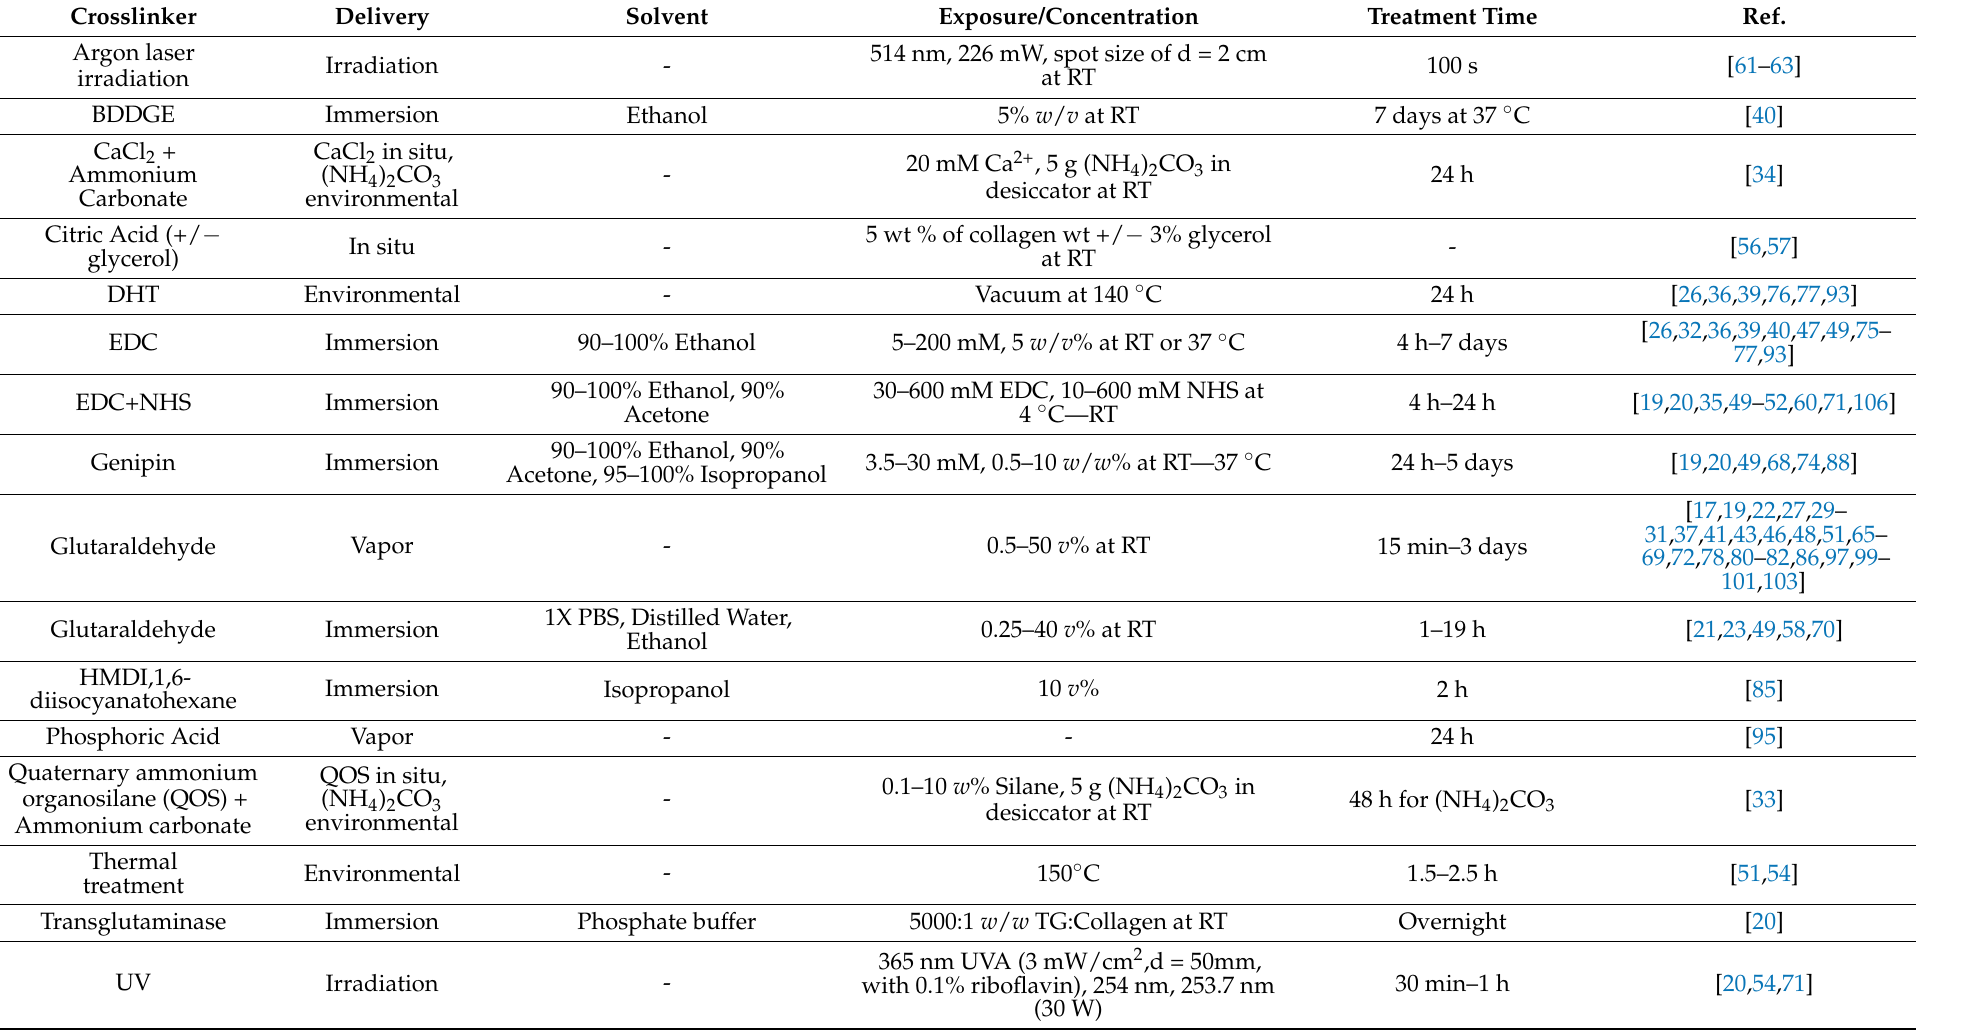
Table 2. Crosslinking methods for collagen and collagen-based electrospun